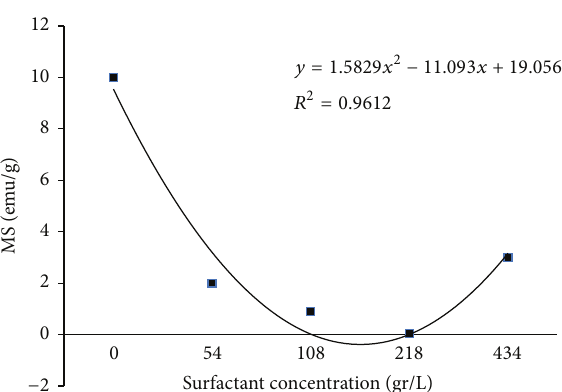
Figure 9: Magnetite saturation of toner synthesize with various types of Fe 3 O 4